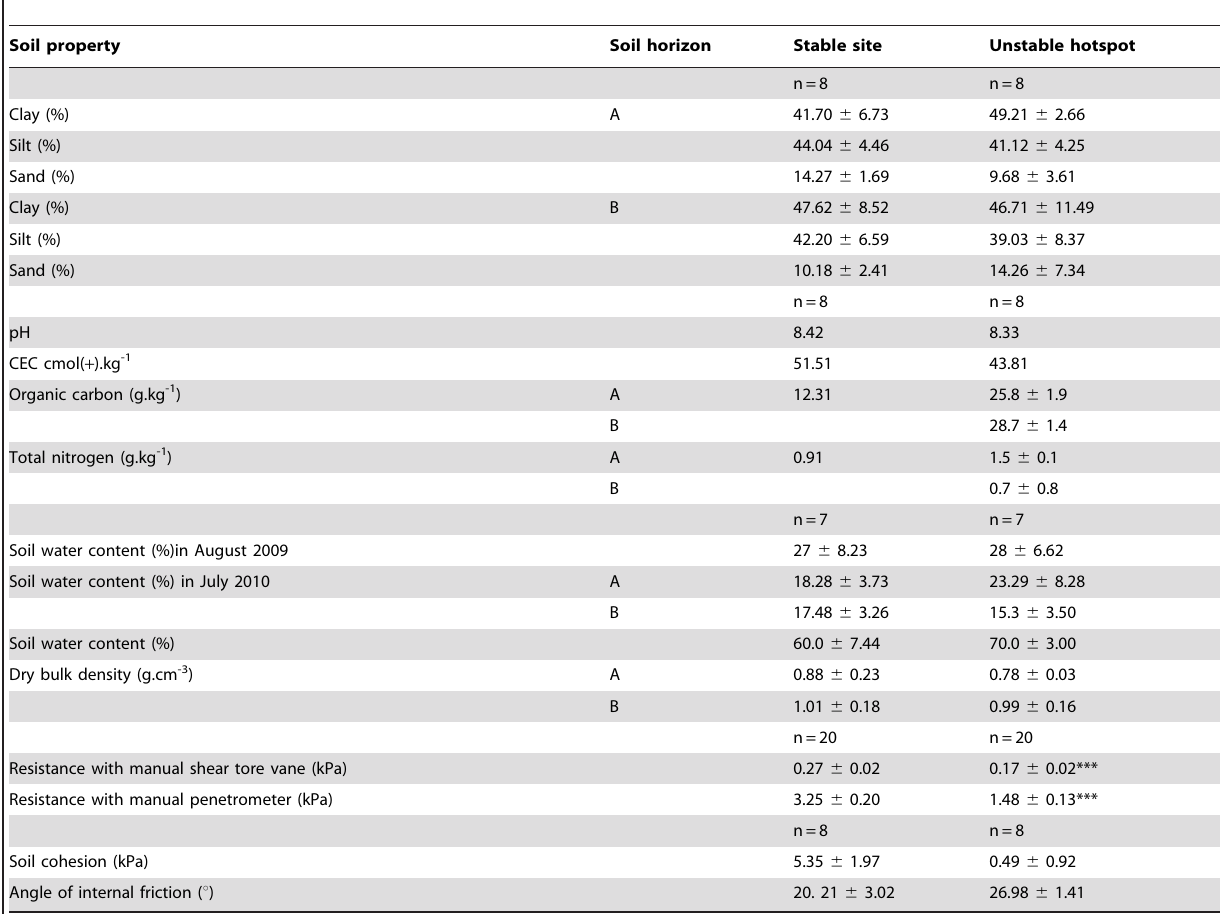
Table 2. Soil textural, chemical and physical characteristics in horizons A and B at the hotspot and stable site.